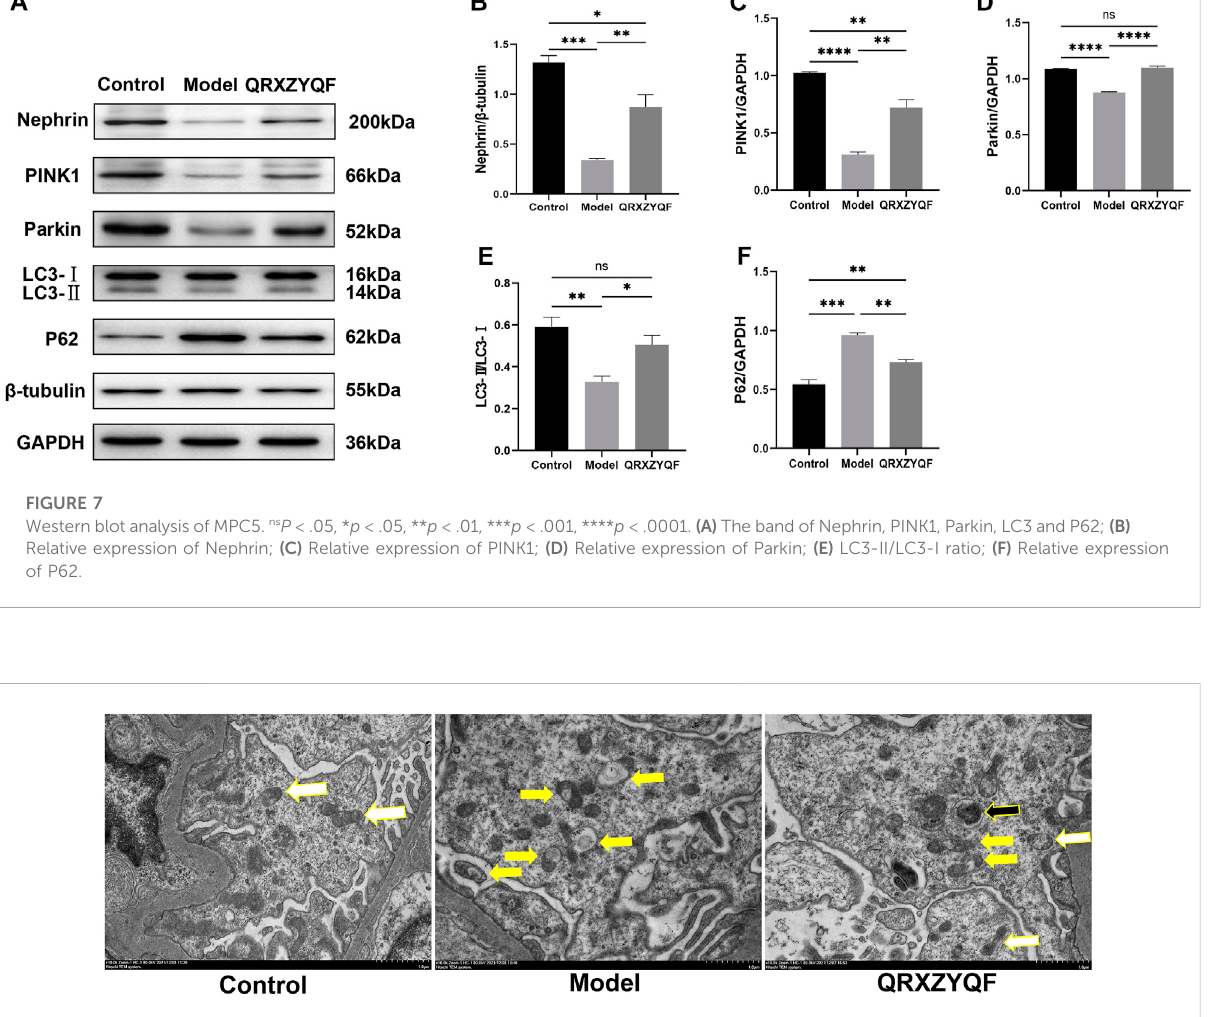
FIGURE 8 Representative TEM images of mitophagy in rats. White arrows indicated normal mitochondria, yellow arrows indicated mitochondria with swollen vacuoles, black arrows indicated residual mitochondria containing electron dense puncta phagocytosed in autophagic vesicles (scale bar: 1 μ